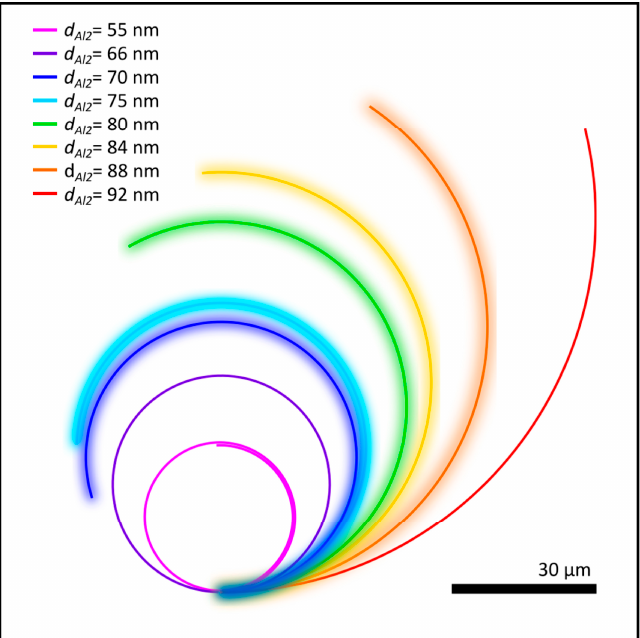
Figure 7. Quantitative representation of the individual degree of curling as a function of different d Al2 values. The curling states with highlighted fading background are those ones revealing pairing in the subsequent figures.